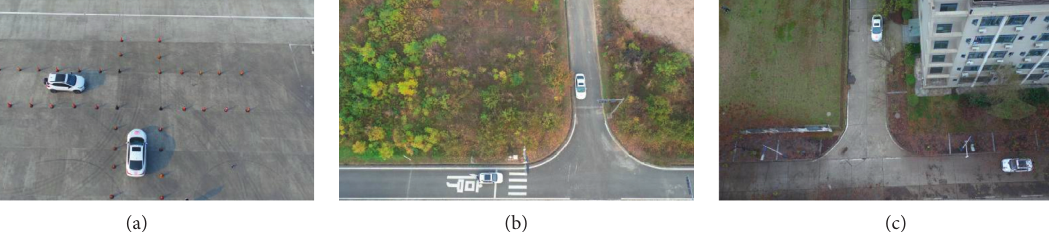
Figure 18: Types of warning.